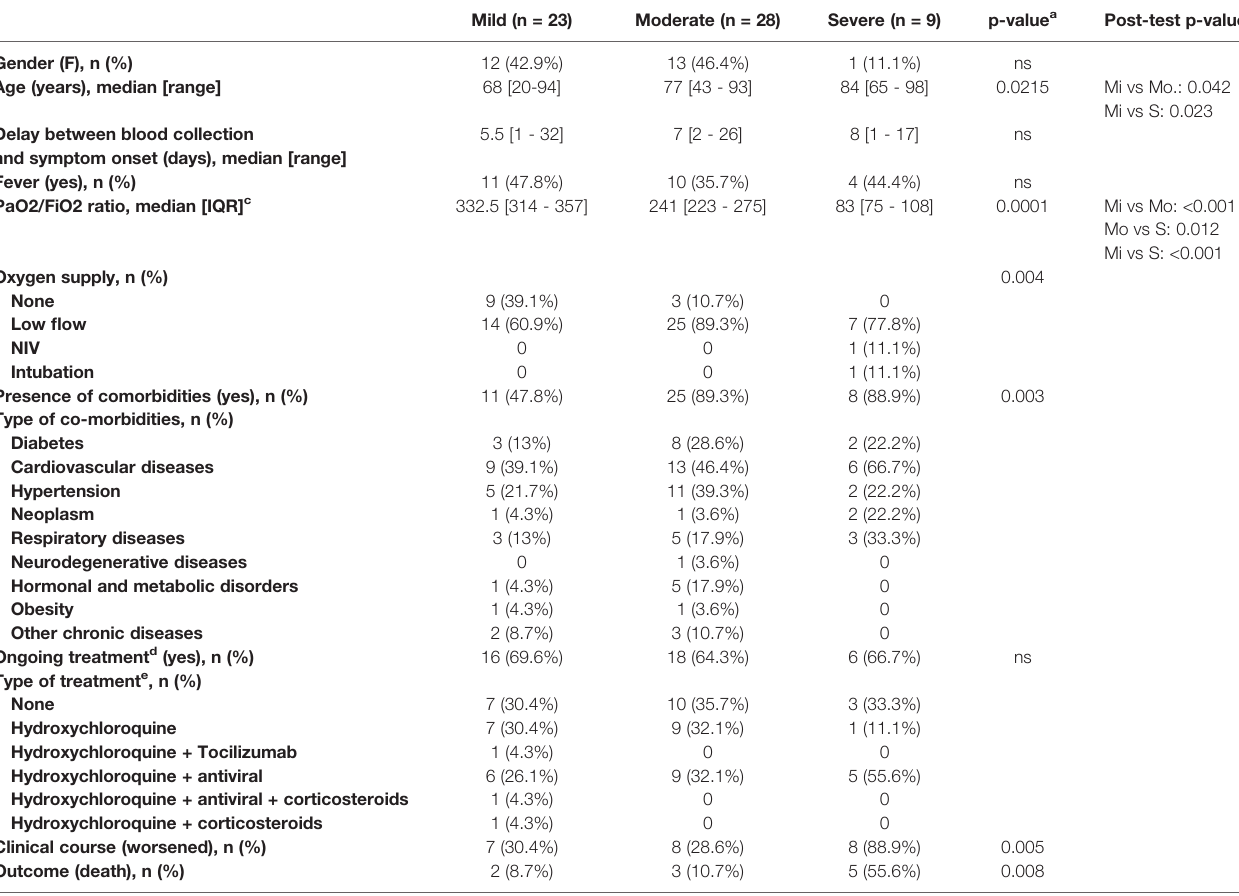
TABLE 1 | Baseline demographic and clinical characteristics of COVID-19